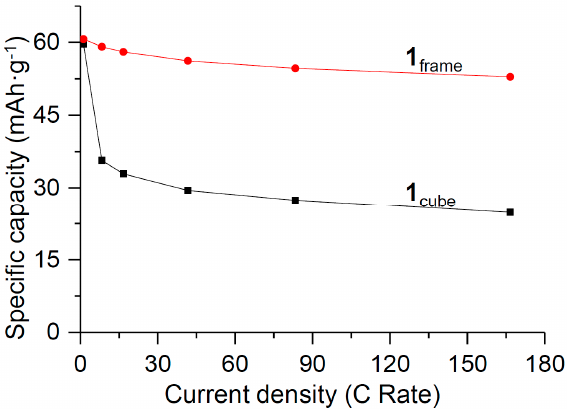
Figure 7. Rate performance of the 1 crystals.